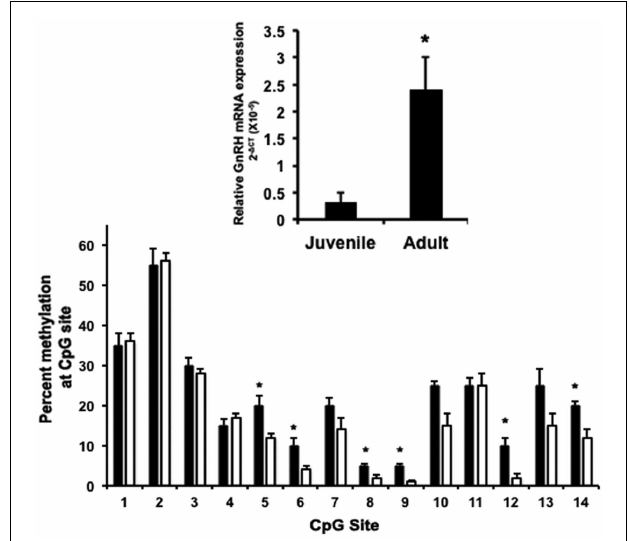
FIGURE 3 | Changes in GnRH mRNA levels and CGI methylation status across puberty in male rhesus monkey medial basal hypothalamic (MBH) tissue .Top panel – total RNA and DNA was extracted from MBH tissue of juvenile ( n = 3, mean age 22.7 ± 2.8months) and adult ( n = 5, mean age of 110 ± 23.4months) rhesus monkeys. GnRH mRNA levels, measured by quantitative PCR, were higher in adult compared to juvenile MBH (* P < 0.05). GnRH mRNA levels are relative to 18s in each sample and analyzed using the ∆ CT method. Bottom panel – DNA extracted from the same samples was bisulfite sequenced. Percent changes in methylation at each CpG site for juvenile ( black bars ) and adult ( white bars ) MBH tissue are shown. CpG methylation status was significantly higher in juvenile compared to adult MBH samples sites 5, 6, 8, 9, 12, and 14 (* P ≤